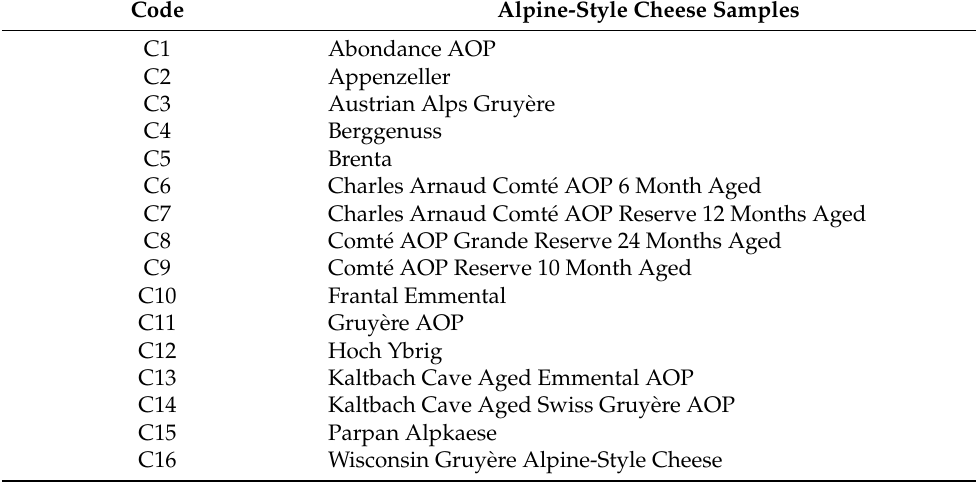
Table A3. Tested Alpine-style cheese samples.